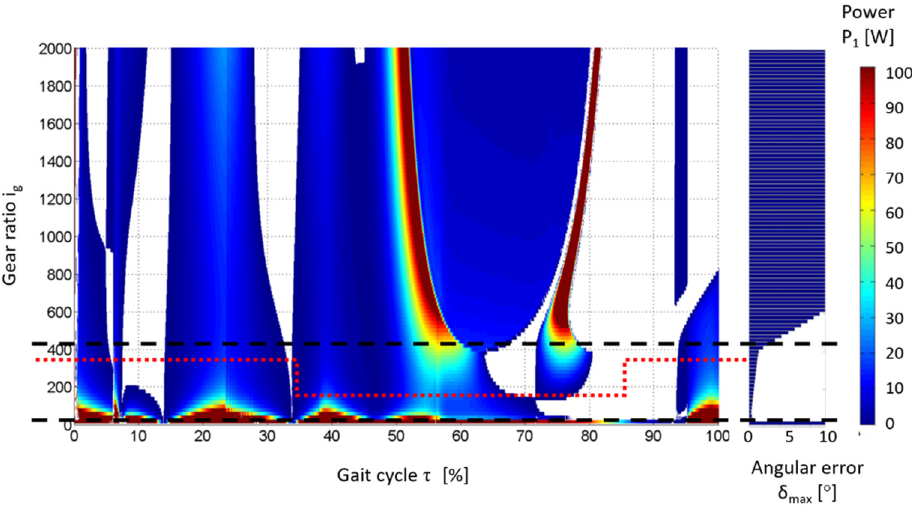
Figure 17. Graph of the instantaneous energy demand at the knee joint and the maximum profile error for the tested gear ratios when performing steps of 0.4 m.